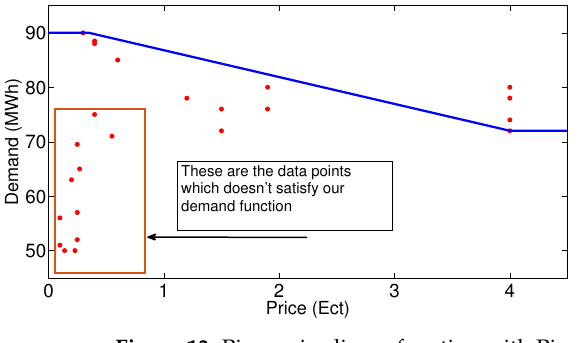
Figure 13. Piece-wise-linear function with Pi and Di.